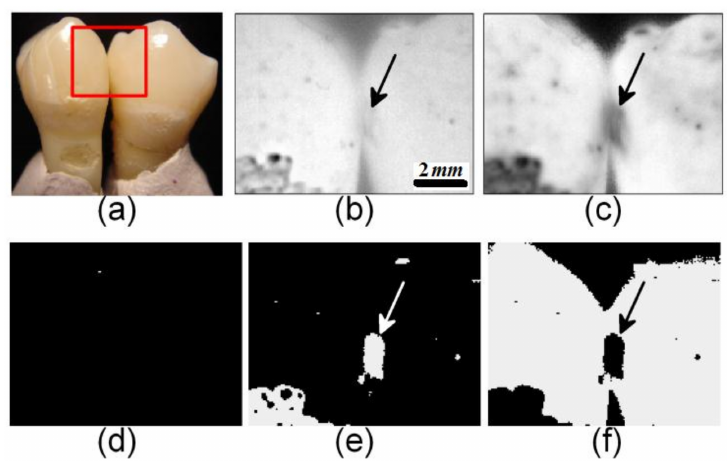
Figure 11. ( a ) teeth matrix with hidden inter-proximal early caries. The rectangle shows the imaged area; ( b ) conventional LIT and ( c ) BPC phase images; TCT images obtained at ( d ) 2.7ms; ( e ) 29.7 ms; and ( f ) 45.9 ms delay times. The white color depicts the pixels coherent to the delayed matched filter. The arrow indicates the hidden interproximal caries